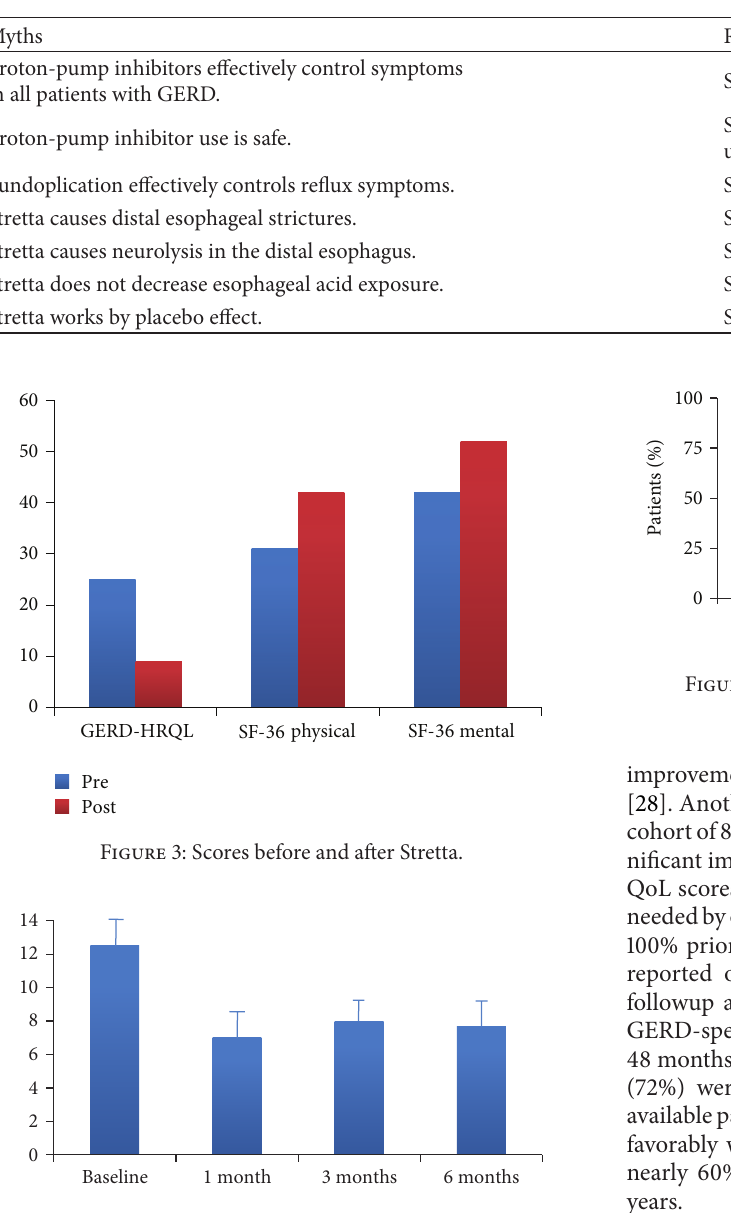
Figure 4: Reflux symptoms 6 months after Stretta.